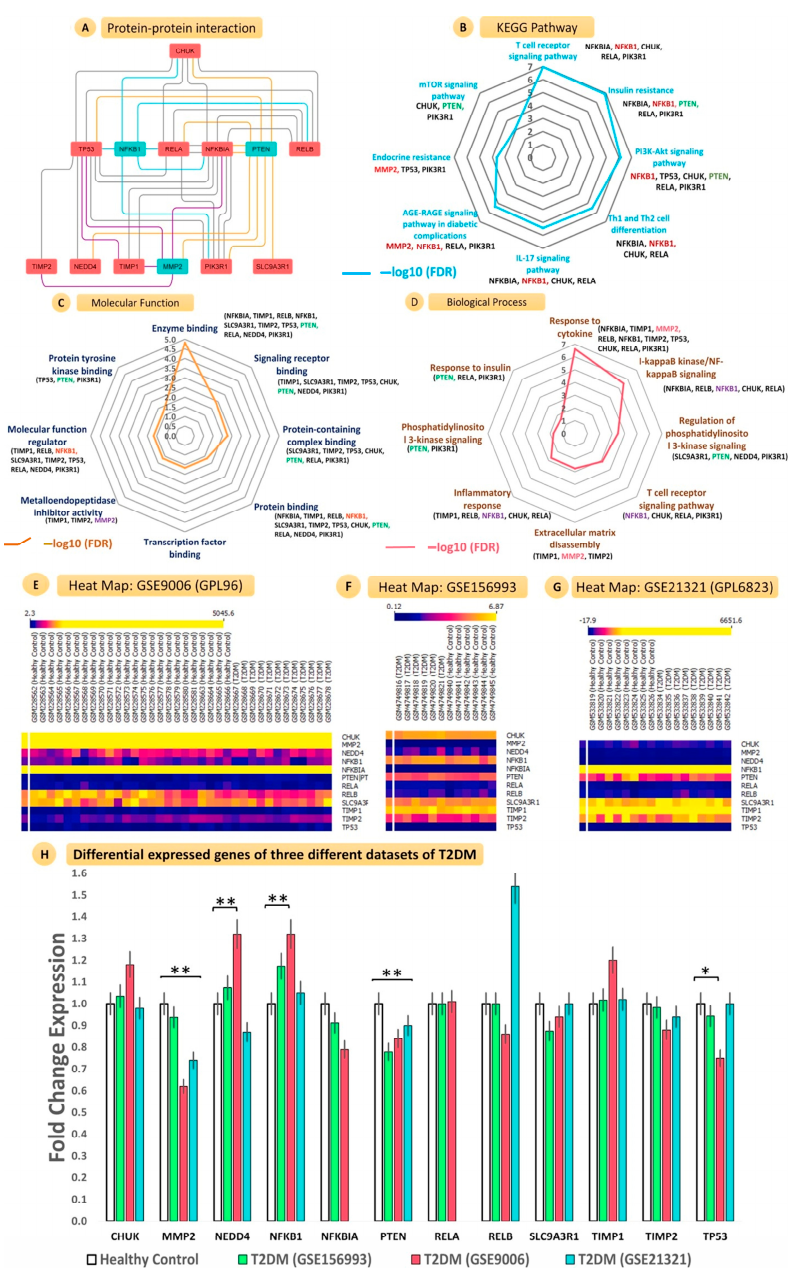
shows the entire FC distribution of the five stages of CKD microRNA-181b-5p, and ( I ) shows the trend plot visualization of FC distribution and of the entire trend of all genes and microRNA in a single graph. Violin plot colour representation: stage 1, sky blue; stage 2, brick red; stage 3, lawn green; stage 4, orange; stage 5, yellow. ** ≤ 0.05.